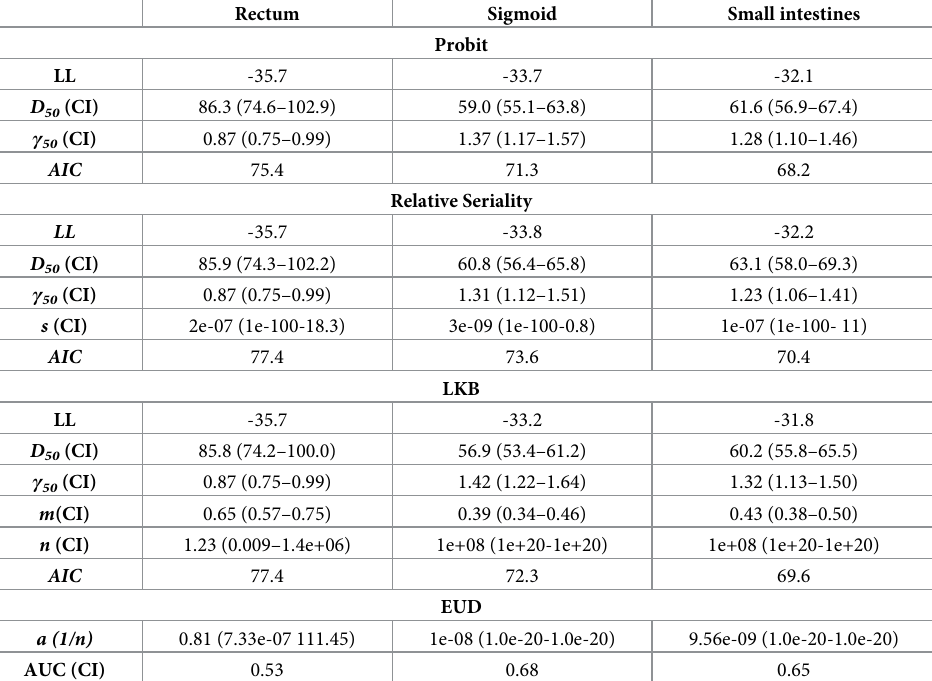
Table 3. The maximum likelihood estimates of the dose-volume response parameters for the three OAR using Probit, RS, LKB and EUD models and the values for the AUC (area under the ROC curve).